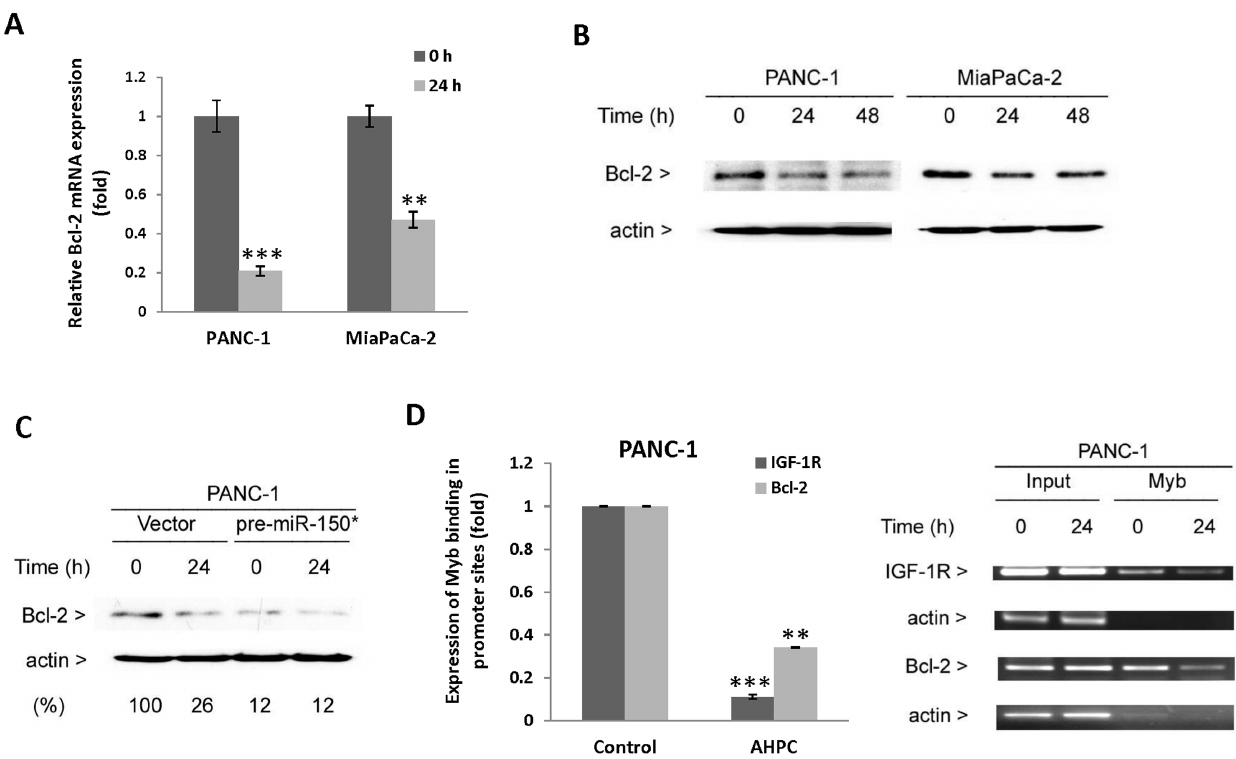
Figure 5. 3-Cl-AHPC mediated decreased c-Myb binding to Bcl-2 and IGF-IR promoters resulted in reduced protein expression . (A and B) 3-Cl-AHPC decreased Bcl-2 mRNA and protein expression. (C) Over-expression of pre-miR-150* reduced Bcl-2 protein expression. (D) 3-Cl-AHPC decreased c-Myb- binding to IGF-1R and Bcl-2 promoter sites in chromatin immunoprecipitation assay. Cells were exposed to 3-Cl-AHPC for 24 h. The error bars represent the mean of three separate determinations 6 the standard deviation (SD). ** and *** ( , 0.01 and , 0.001) were significantly different in comparison between control to 3-Cl-AHPC treated mRNA and Myb binding in promoter sites using t -Test.